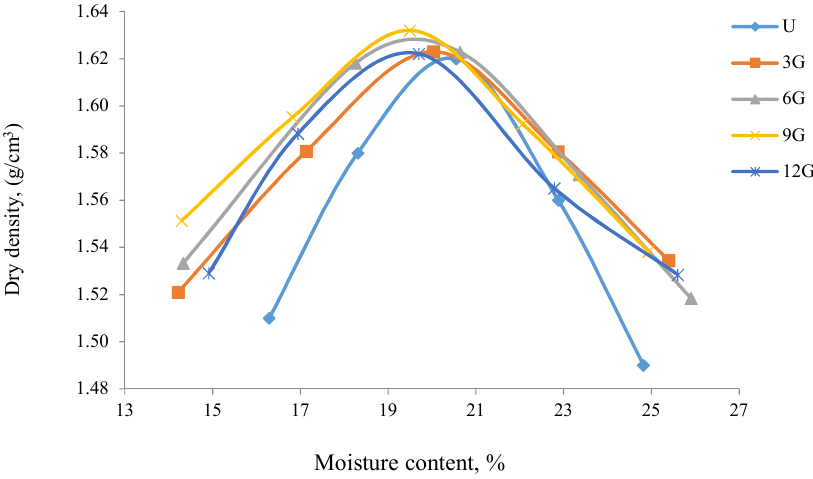
Figure 1. Compaction parameters of soil with different GGBS contents.